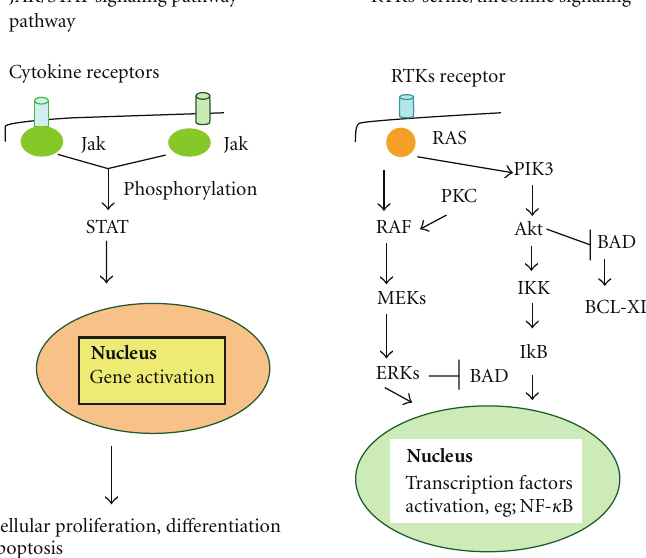
Figure 2: Cellular signaling pathways that control normal hematopoiesis and apoptosis. Molecules participating in these pathways could be used as therapy targets in leukemias. Jak/Stat pathway is very important in leukemias, since disorders of its function lead to malignancies, for example, chromosomal translocation TEL-Jak2. It participates in apoptosis regulation with various ways, for instance some Stats (2 and 3) are the mediators of the antiapoptotic e ff ects of cytokines, like IL-6 and IL-2. RTKs are membrane-bound enzymes that phosphorylate and activate several signaling proteins. Example of this receptor is the FLT3R and mutations of the FLT3 gene have been reported in some cases of AML. Other molecules like ERKs and Akt are involved in apoptosis through suppressing bad mediated apoptosis. Jak: Janus kinase. STAT: signal transducer and activator of transcription. MEKs: MAPK kinases. MAPK: mitogen-activated protein kinase. ERKs: extracellular signal-regulated kinases. RTK: receptor tyrosine kinase. PKC: protein kinase C. FLT3R: FMS-like tyrosine kinase 3 receptor. Akt: protein kinase B (PKB). PIK3: phosphatidylinositol 3-kinase. IkB: inhibitor of nuclear factor kB. NF- κ B: nuclear factor